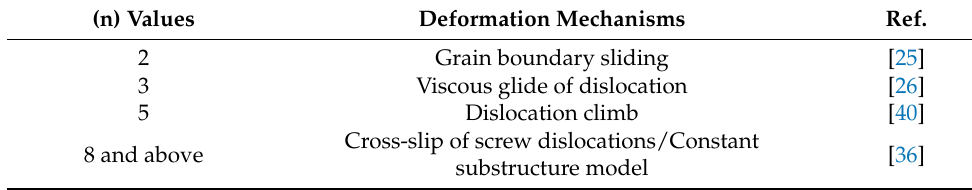
Table 2. Stress exponent values and associated deformation mechanisms.